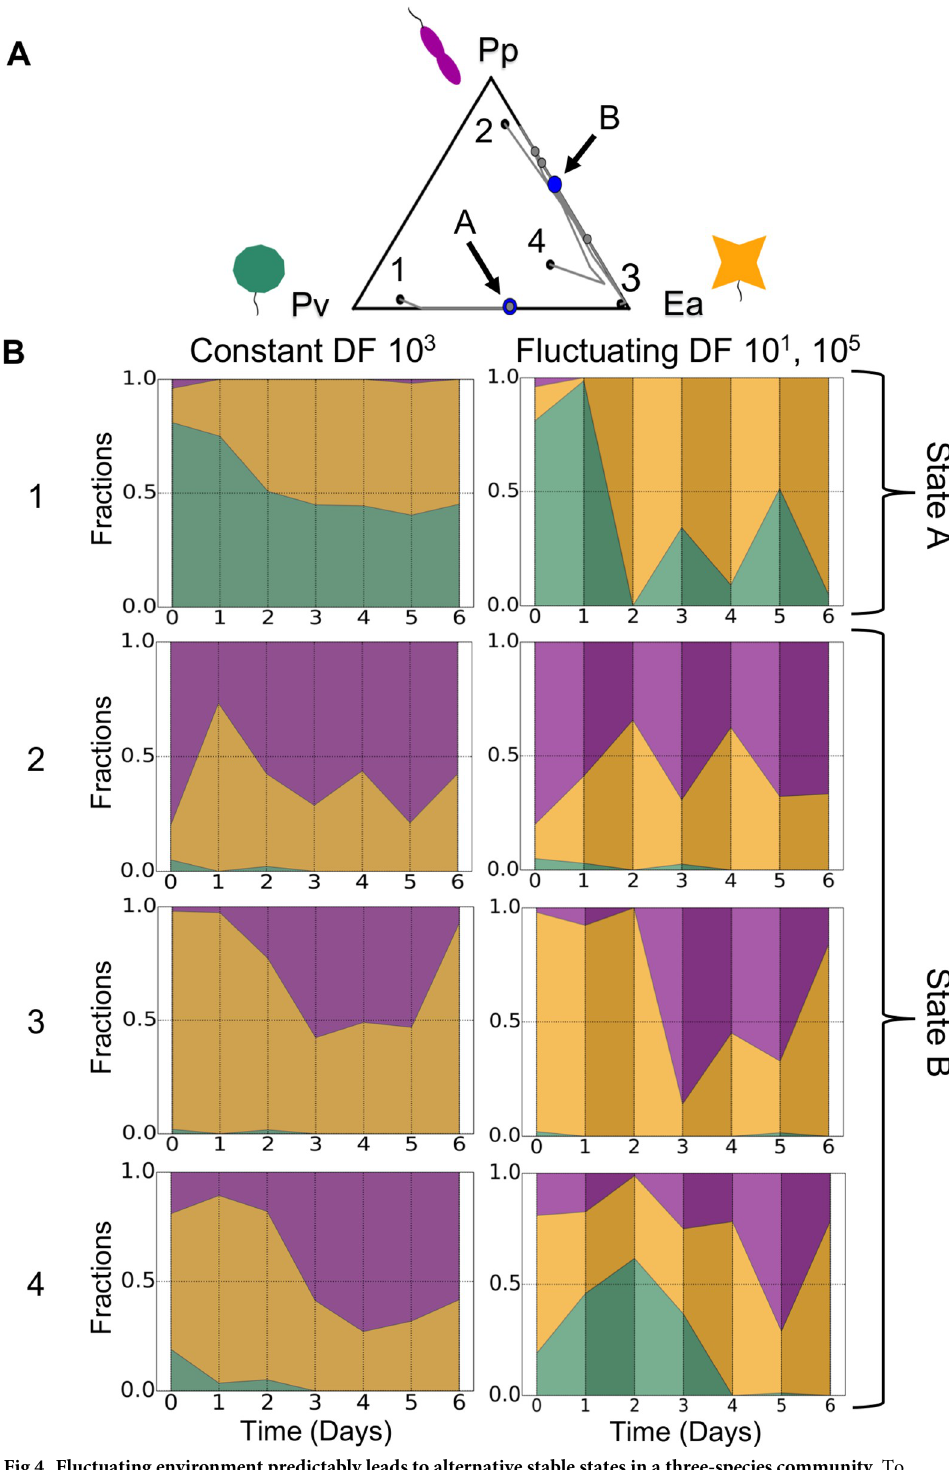
Fig 4. Fluctuating environment predictably leads to alternative stable states in a three-species community. To ensure that the time-averaging prediction is not only applicable to simple two-species communities, we tested our results in a three-species environment. A : A ternary plot shows the outcomes of a coculture with all three species, Pv , Pp , and Ea , in a constant environment with dilution factor (DF) 10 3 . The time trajectories, indicated by the grey lines, end at one of two alternative stable states (shown in blue; for state B, we plot the average of the three trajectories).